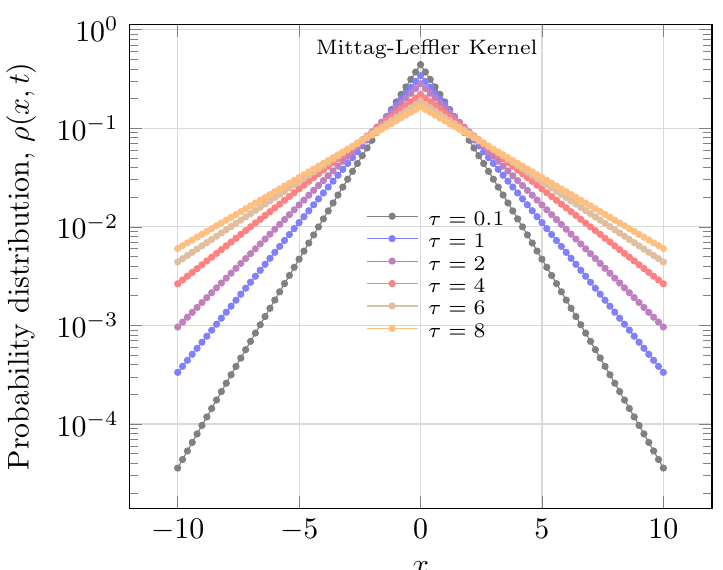
Figure 4. This curves illustrate the changes of distribution ρ ( x , t ) caused by the Mittag-Leffler kernel (Equation (4) in Equation (1)), and the usual (Brownian motion) case Equation (4)). Considering , ϕ ( x ) = δ ( x ) ,